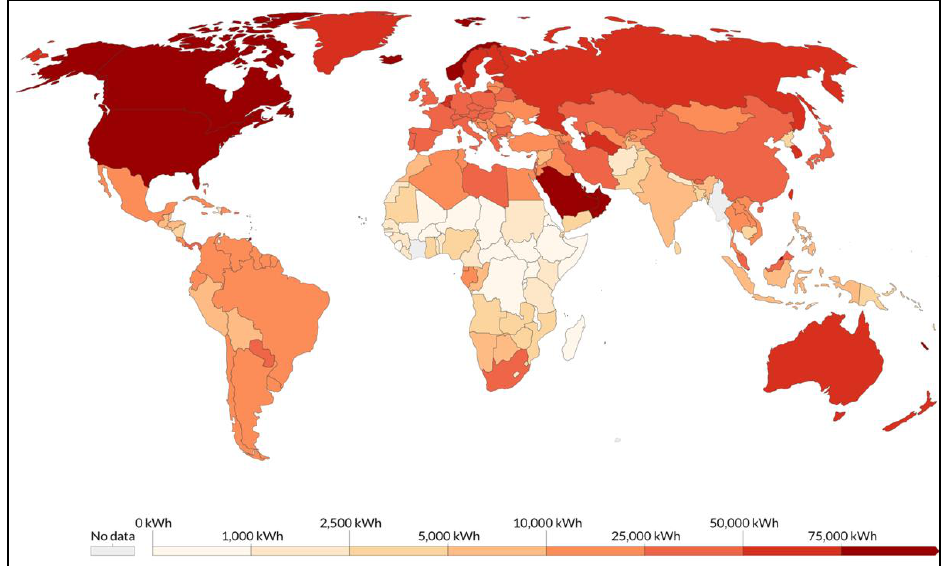
Figure 6. Per capita global energy consumption (kWh) in 2019, derived from [19].